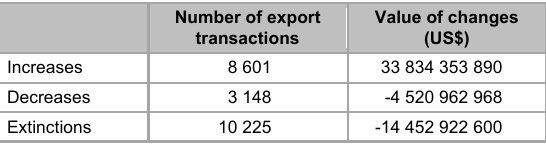
Intensive margin over the period (1994 to